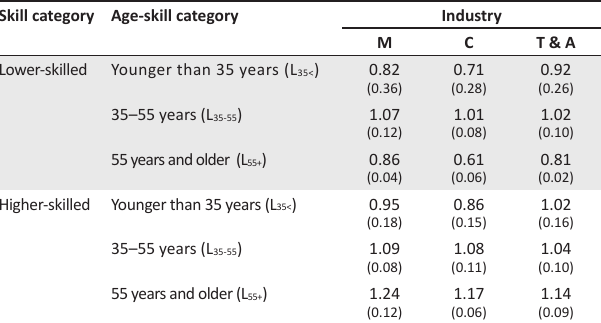
TABLE 2: Marginal productivity ratios per age-skill category for the three industries. Skill category Age-skill category